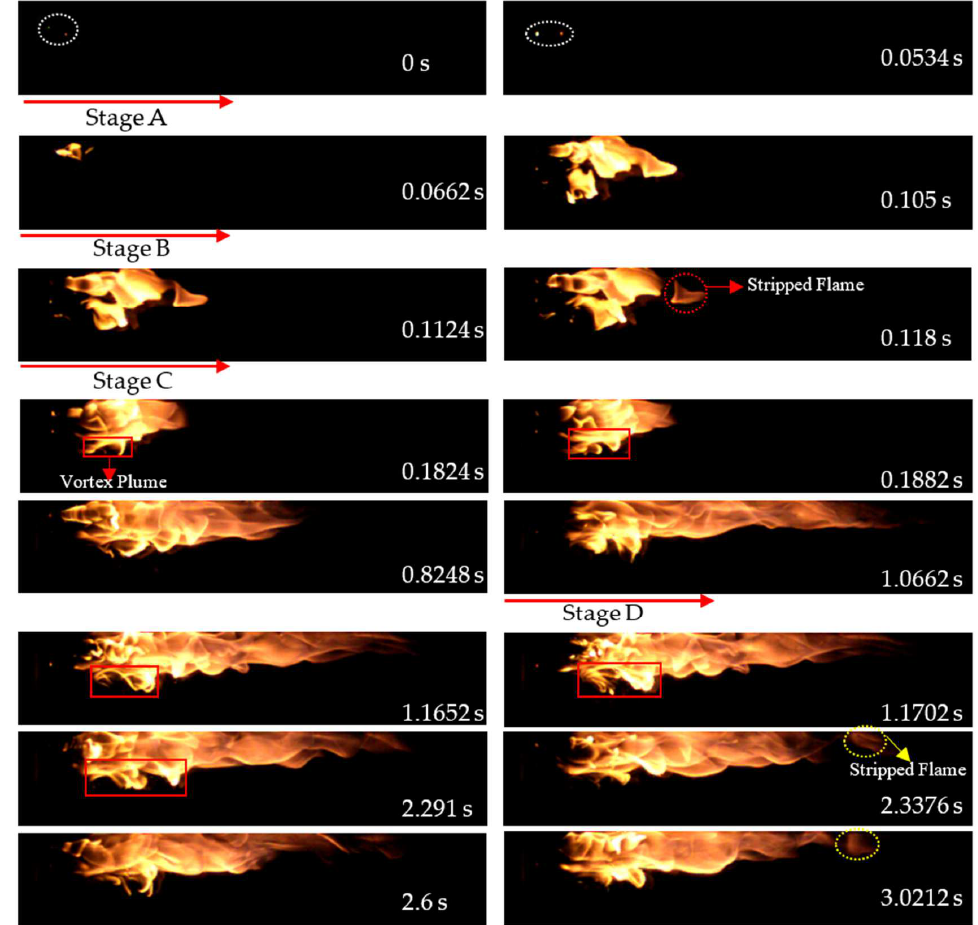
Figure 5. Flame propagation under the air flow velocity of 1.4 m/s and the diesel flow rate of 15.2 mL/min.